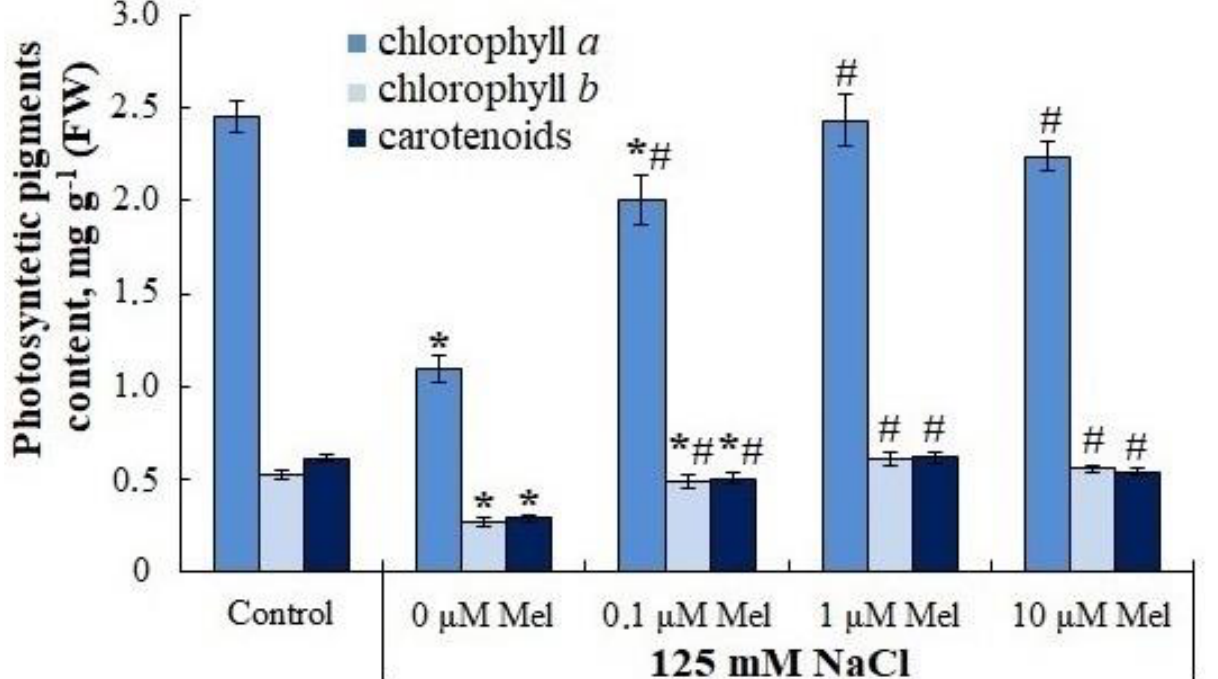
Figure 1. Influence of melatonin and chloride salinity on photosynthetic pigments content in Solanum tuberosum leaves. Asterisks (*) indicate significant differences from the control variant and the «#» indicates significant differences from the «125 mM NaCl» variant ( p < 0.05).